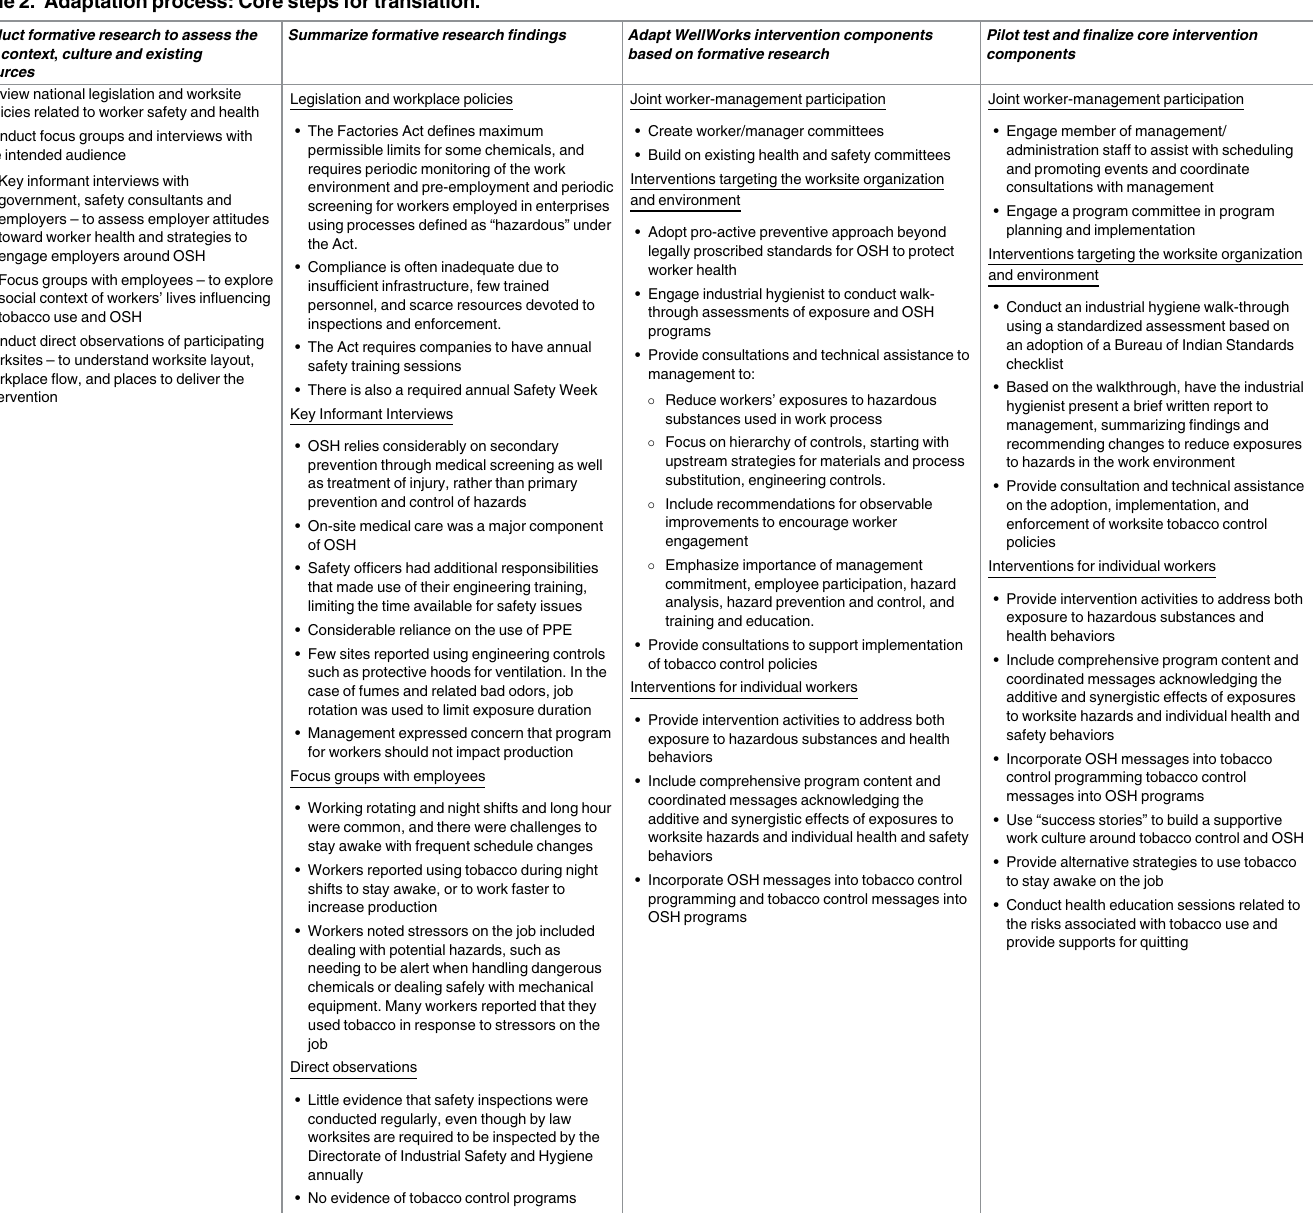
Table 2. Adaptation process: Core steps for